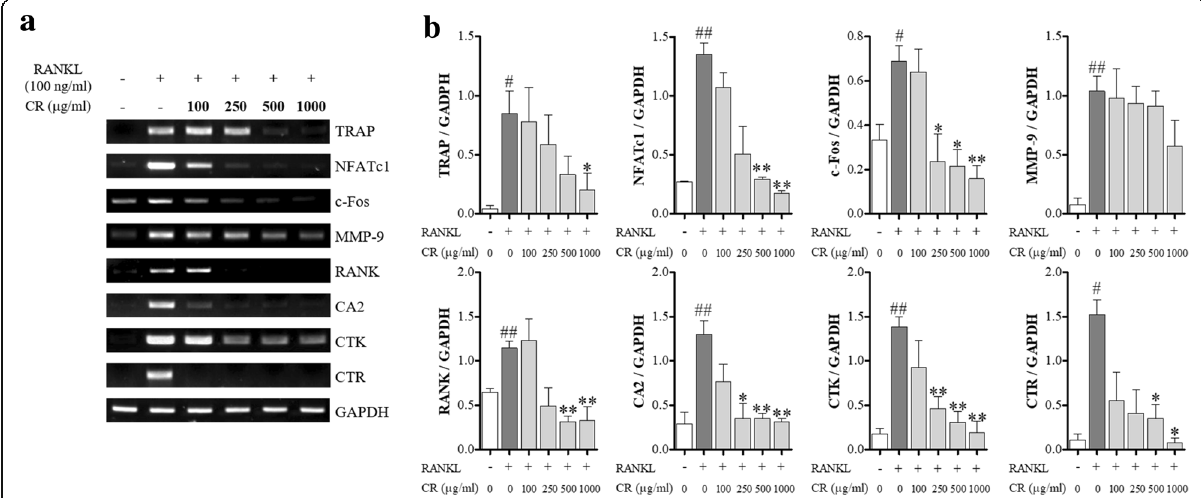
Fig. 6 Effect of CR on the mRNA expression of osteoclastogenesis marker genes by RANKL. a The mRNA expressions were detected by RT-PCR. b osteoclastogenesis genes were normalized to GAPDH. Columns and error bars represent the mean ± S. E of three independent experiments. ## p < 0.01, # p < 0.05 compared with normal and ** p < 0.01, * p < 0.05 compared with the